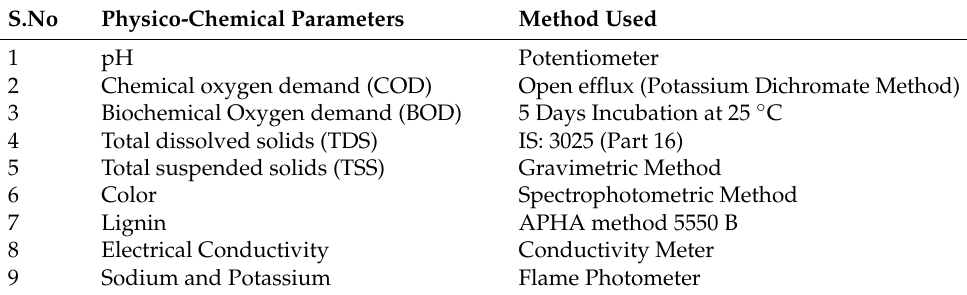
Table 1. Physico-chemical parameters for